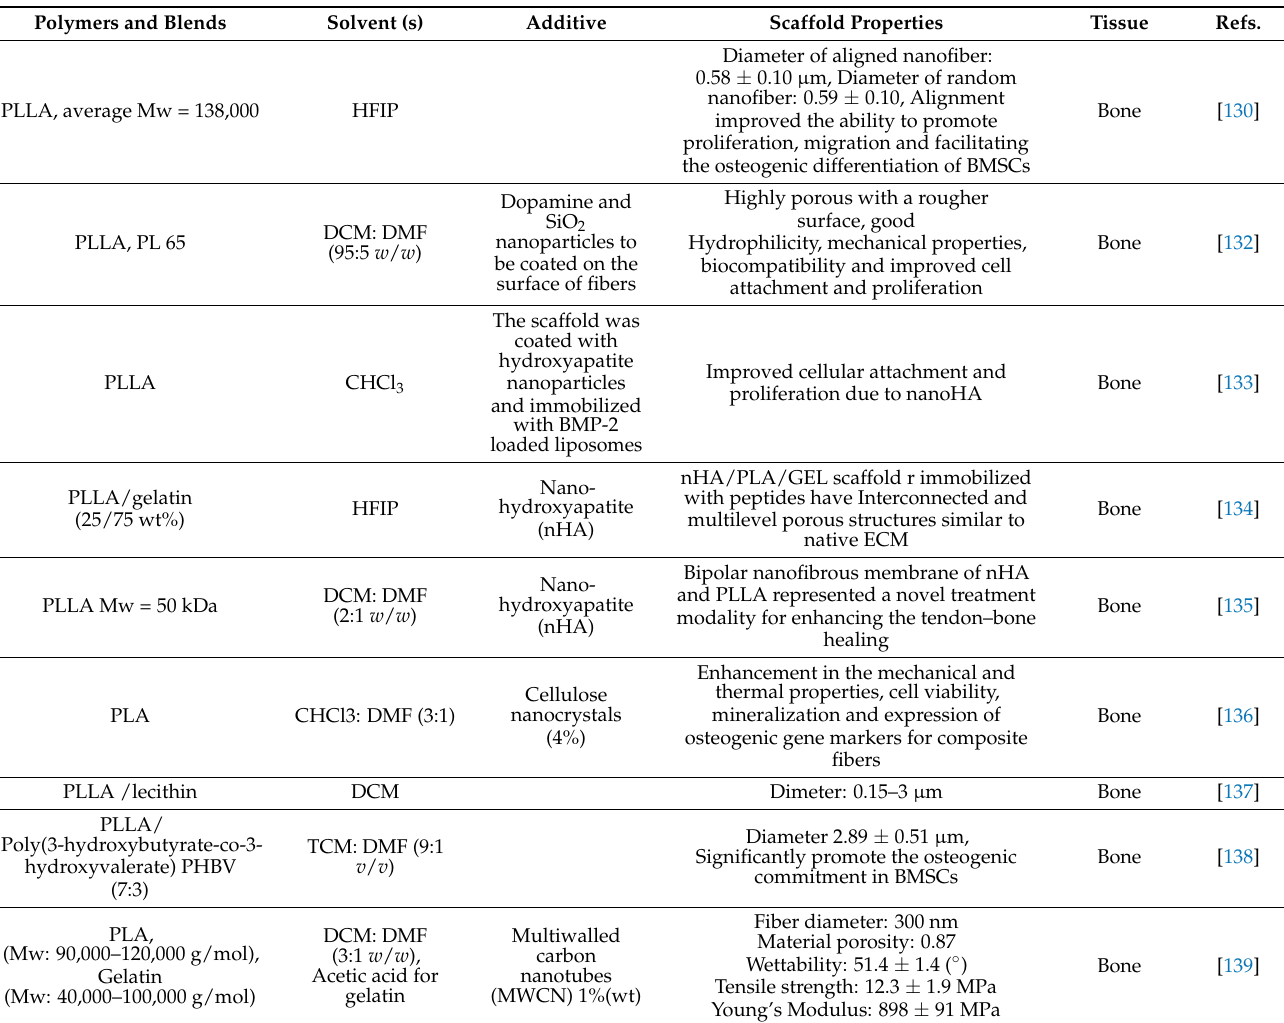
Table 3. Different studies in which electrospun PLA fibers have been used for tissue engineering